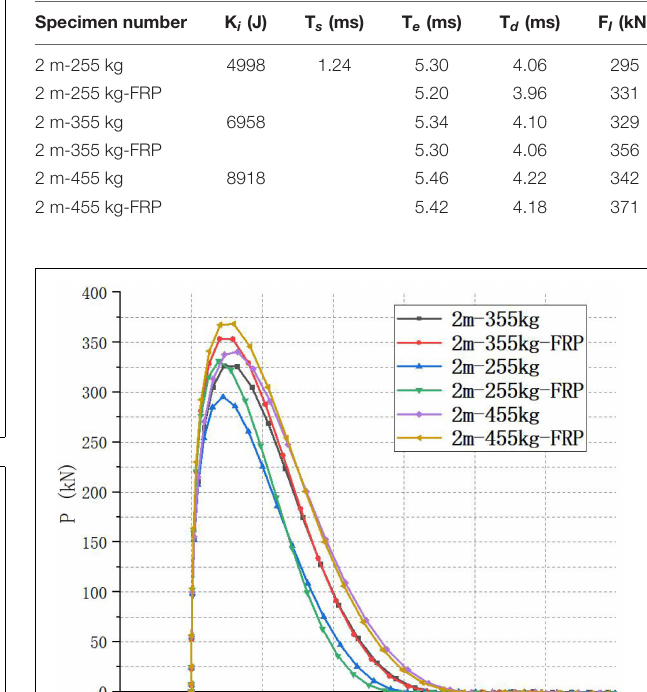
TABLE 6 | Peak and duration of impact force at different weights.